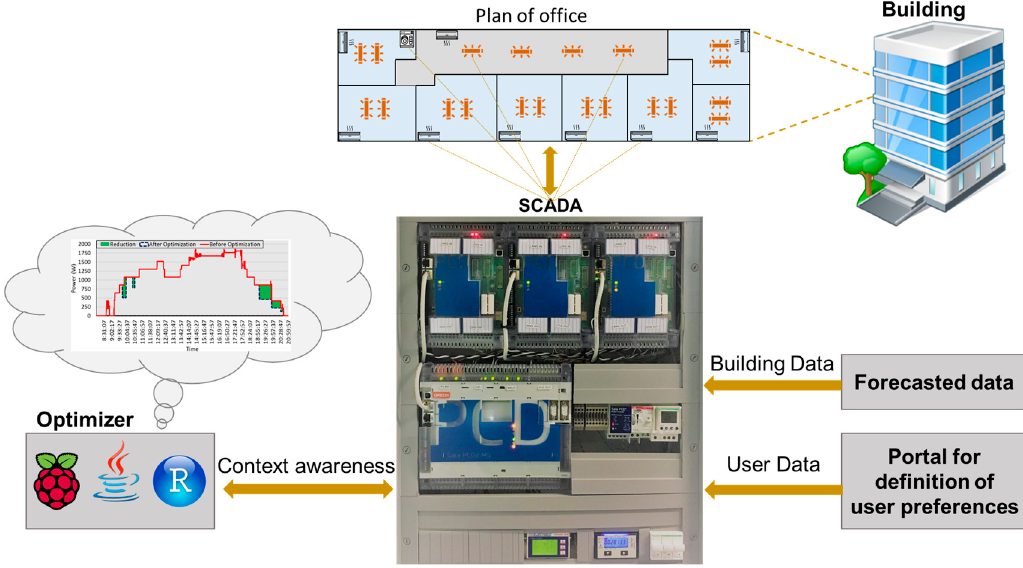
Figure 1. The overall architecture of the developed Supervisory Control and Data Acquisition (SCADA) system in an office building.